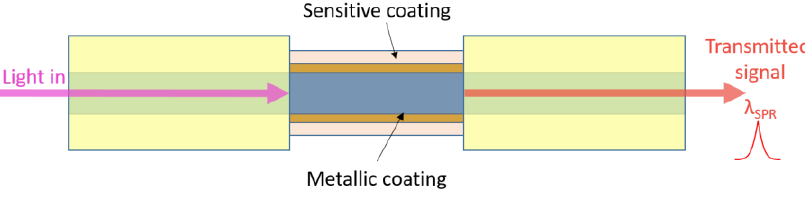
Figure 6. Schematic representation of a SPR-based optical fibre sensor.